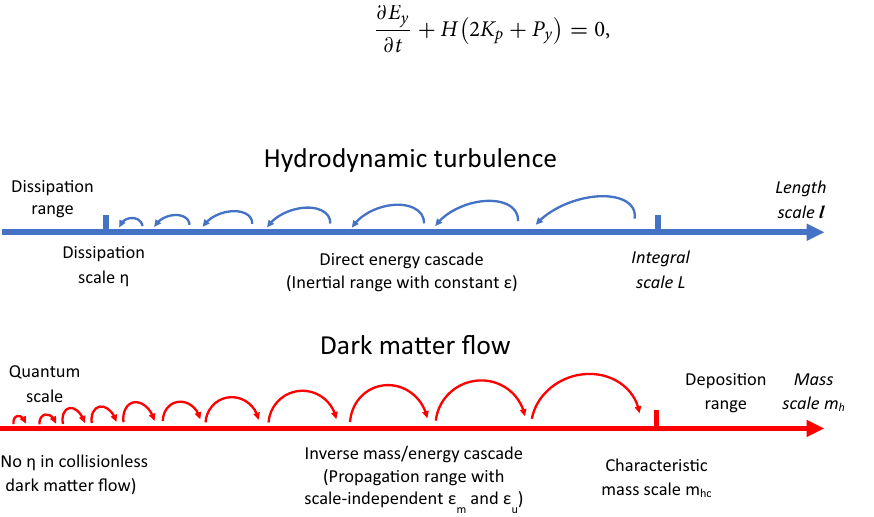
Figure 1. Schematic plot of the direct energy cascade in turbulence and the inverse mass and energy cascade in dark matter flow. Haloes merge with single mergers to facilitate a continuous mass and energy cascade to large scales. Scale-independent mass flux ε m and energy flux ε u are expected for haloes smaller than a characteristic mass scale (propagation range similar to the inertial range in turbulence). Mass cascaded from small scales is consumed to grow haloes at scales above the characteristic mass (the deposition range similar to the dissipation range in turbulence), where mass and energy flux become scale-dependent 41–43